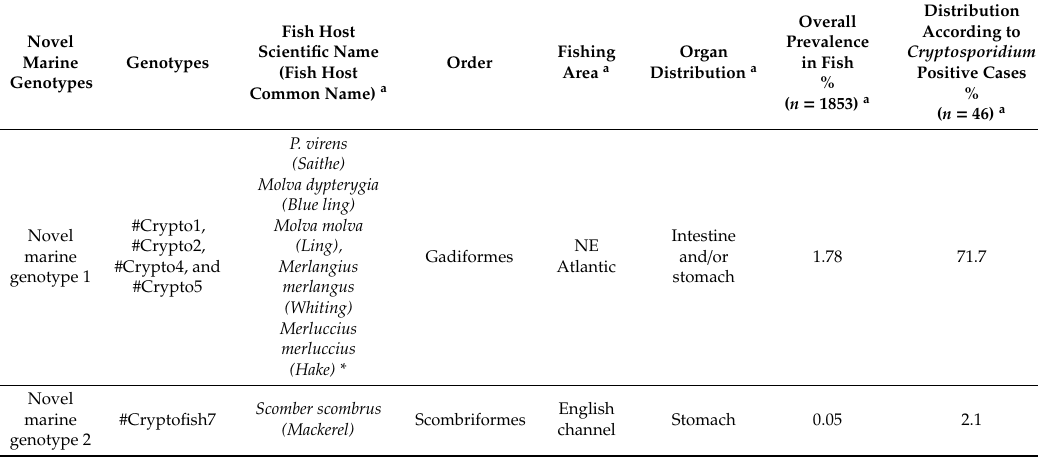
Table 3. Characteristics of novel piscine Cryptosporidium genotypes identified in the present